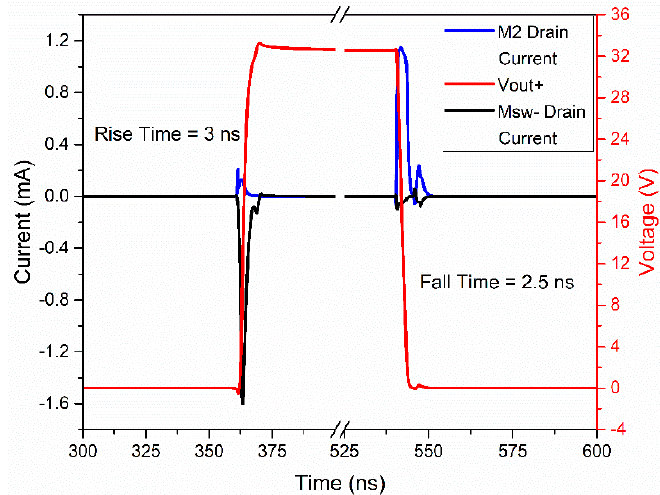
Figure 3. Voltage and source and sink currents in the output node (Vout+) [15].